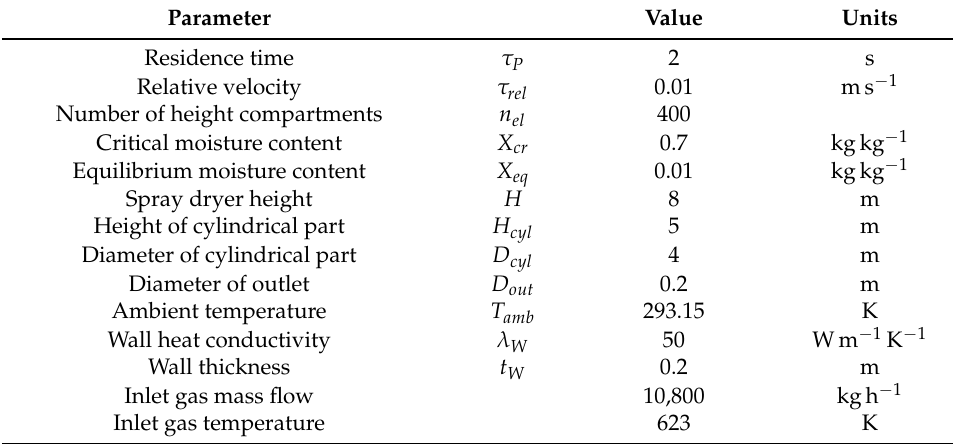
Table A7. Model parameters of the Spray dryer unit used in the flowsheet simulations of the zeolite catalyst production process.